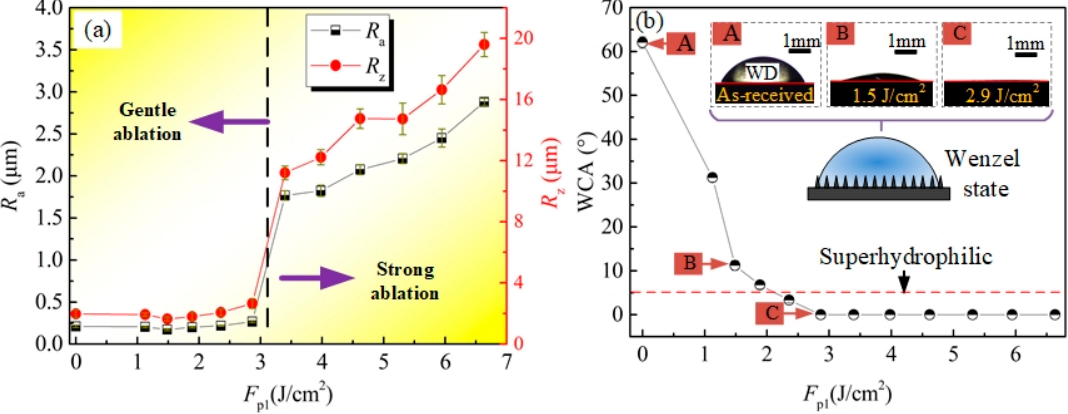
Figure 4. Effect of F p1 on the ( a ) surface roughness and ( b ) WCA of the Ti–6Al–4V surfaces without silanization.